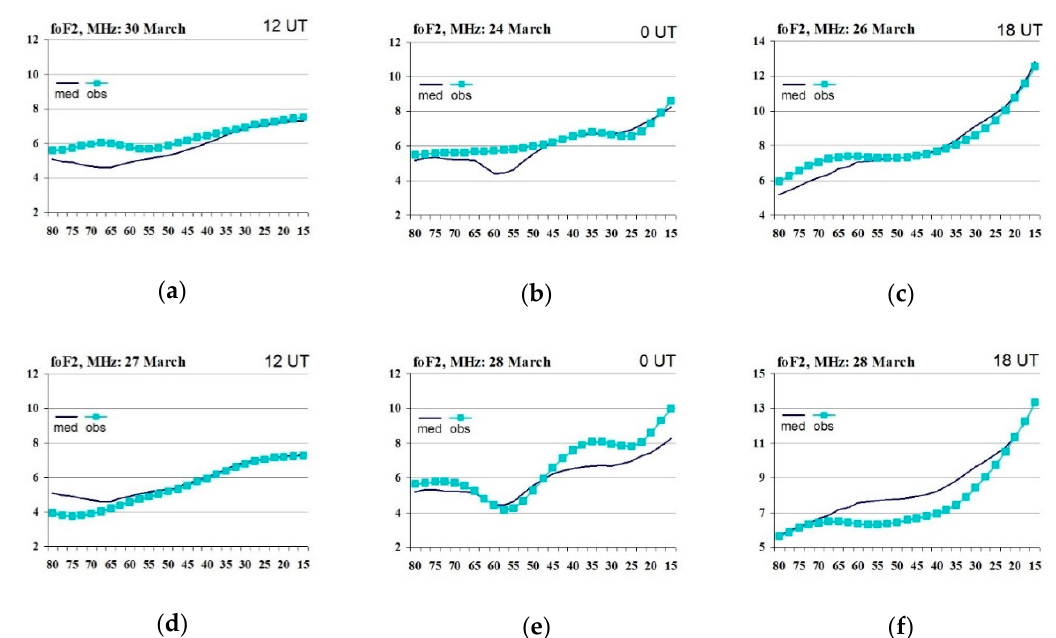
Figure 13. foF2 latitudinal dependence during 21–31 March: ( upper panels ) typical examples during quiet geomagnetic conditions (control days); ( lower panels ) variations at the same hours but during the storm. Curves designations are the same as in Figure 12.